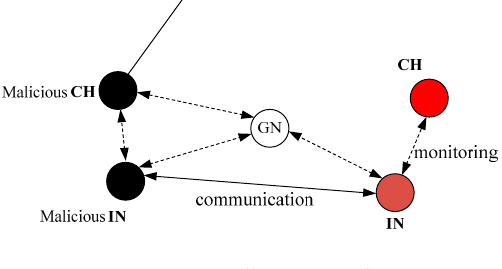
Figure 6. Collusion attack.